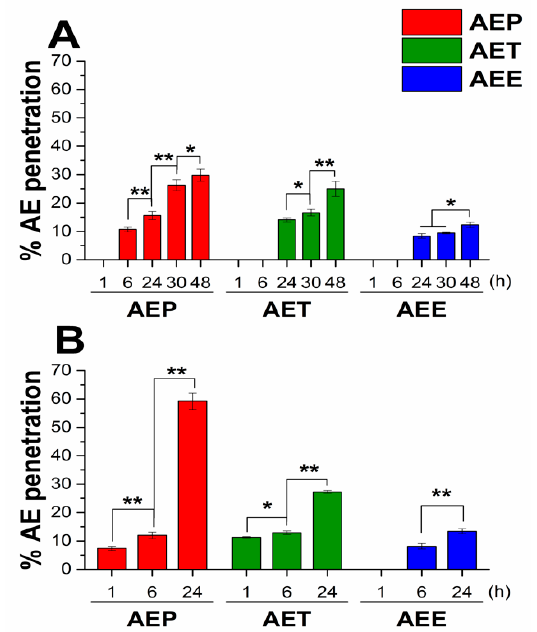
Figure 2. Results of the interaction study between unilamellar liposomes (Uls) and different formulations of Artemisia essential oil (AE) at 30 °C for 48 h ( A ) and at 37 °C for 24 h ( B ), experiments were performed in triplicate. AEP: Pickering emulsion, AET: conventional emulsion, AEE: ethanolic solution. c[AE] = 200 µg/mL ( * P < 0.05 and ** P < 0.01 , mean ± SD).